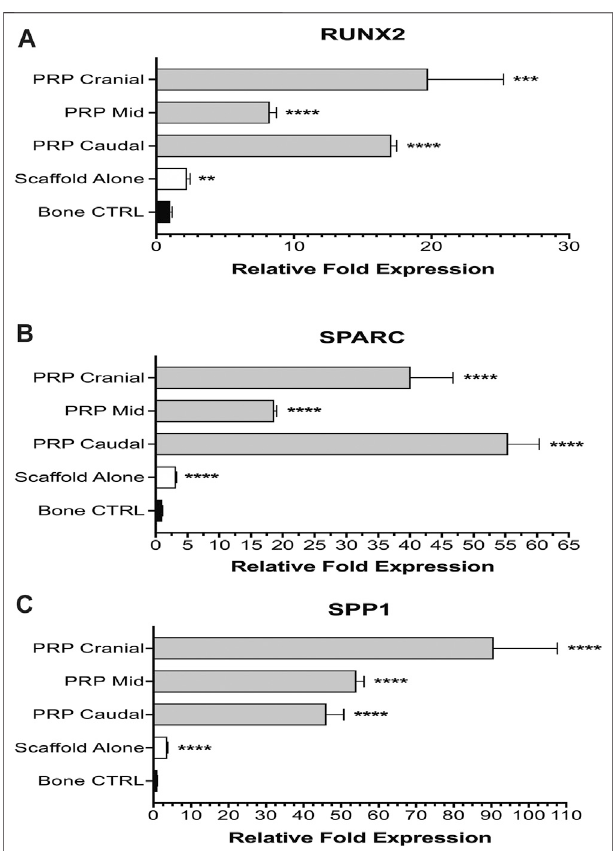
FIGURE 6 | Molecular analysis of osteogenesis. Group 1 specimens were compared with separate cranial, mid, and caudal regions of Group 2 specimens for expression of osteogenic genes: RUNX2 (A) , SPARC (B) , and SPP1 (C) .